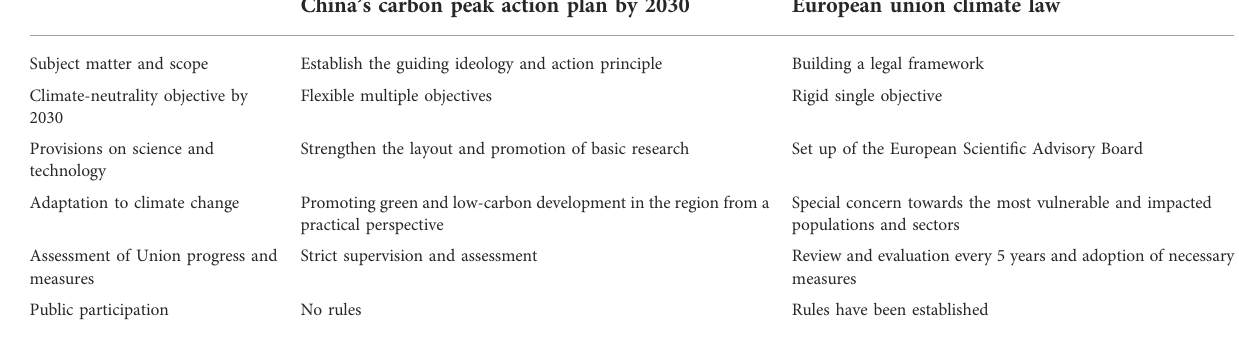
TABLE 1 Differences between the carbon peak legislation of China and the